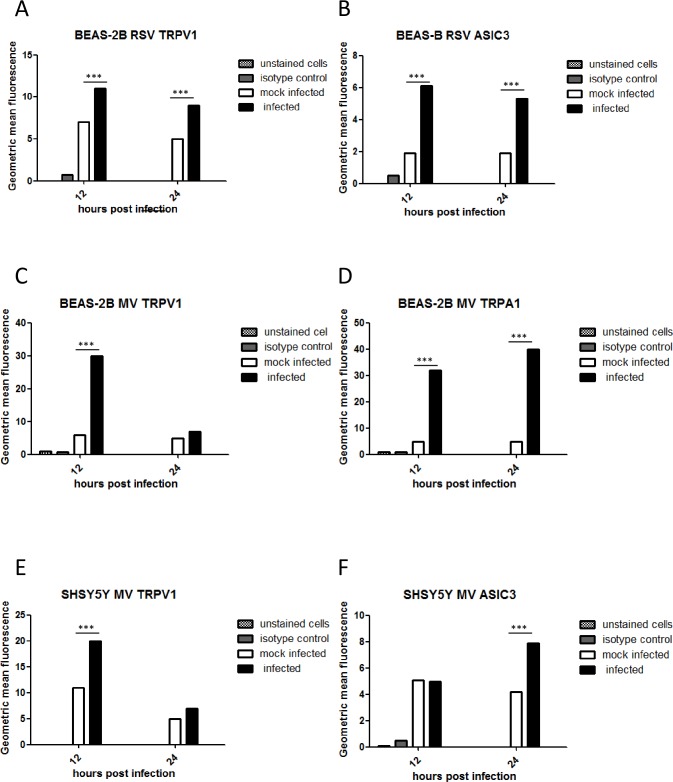
TRPV1, TRPA1 and ASICS3 protein expression is up-regulated by virus infection.(A to D) BEAS-2B cells were infected with RSV (MOI 0.1) and MV (MOI 1). (E and F) SHSY5Y cells were infected with MV (MOI 1). TRPV1, TRPA1 or ASIC3 expression was determined by flow cytometry at 12 and 24 hpi. The levels were quantified by geometric mean fluorescence intensity (GMFI). (A) RSV TRPV1, (B) RSV ASCI3, (C) MV TRPV1, (D) MV TRPA1. The results are representative of 3 independent experiments.